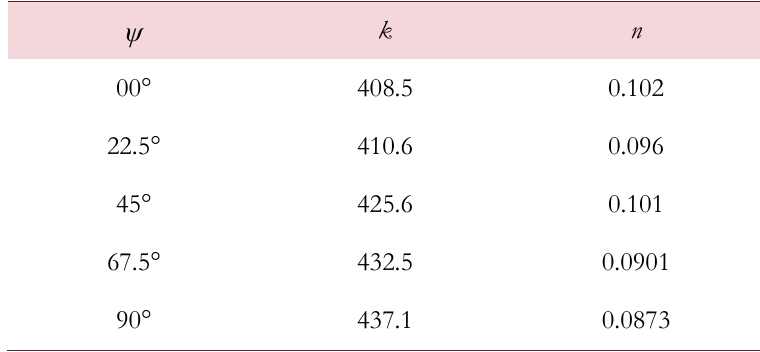
Table 2: Identification of the constants of hardening law for different tractions tests.